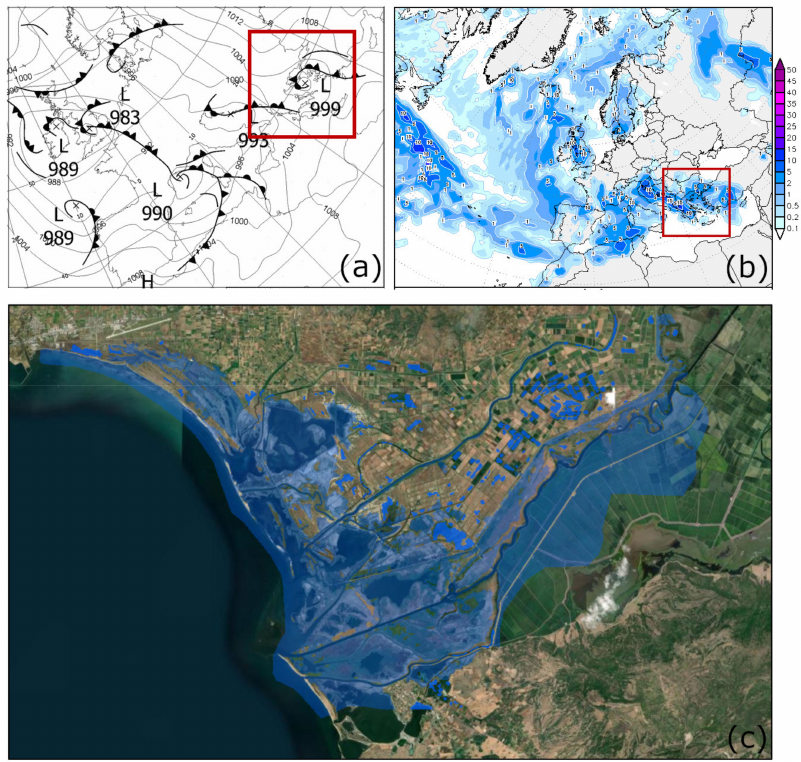
Figure A7. As in Figure A1, but for the 2018 flood